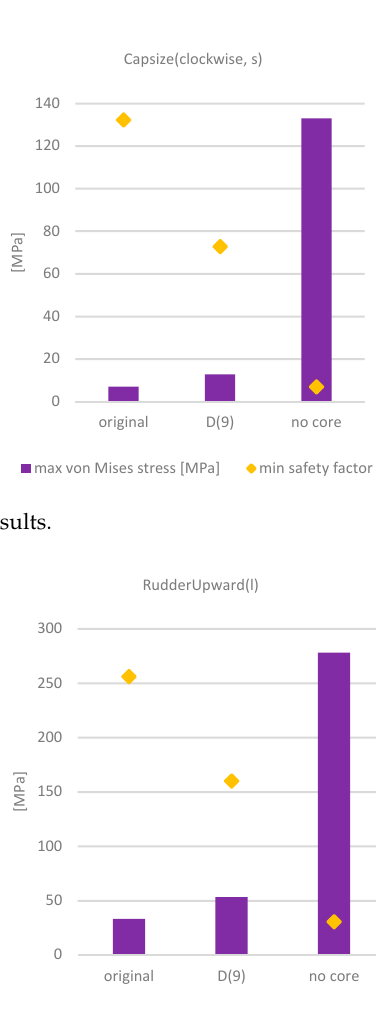
Figure 9. Working (+10°, l ) load case analysis results.